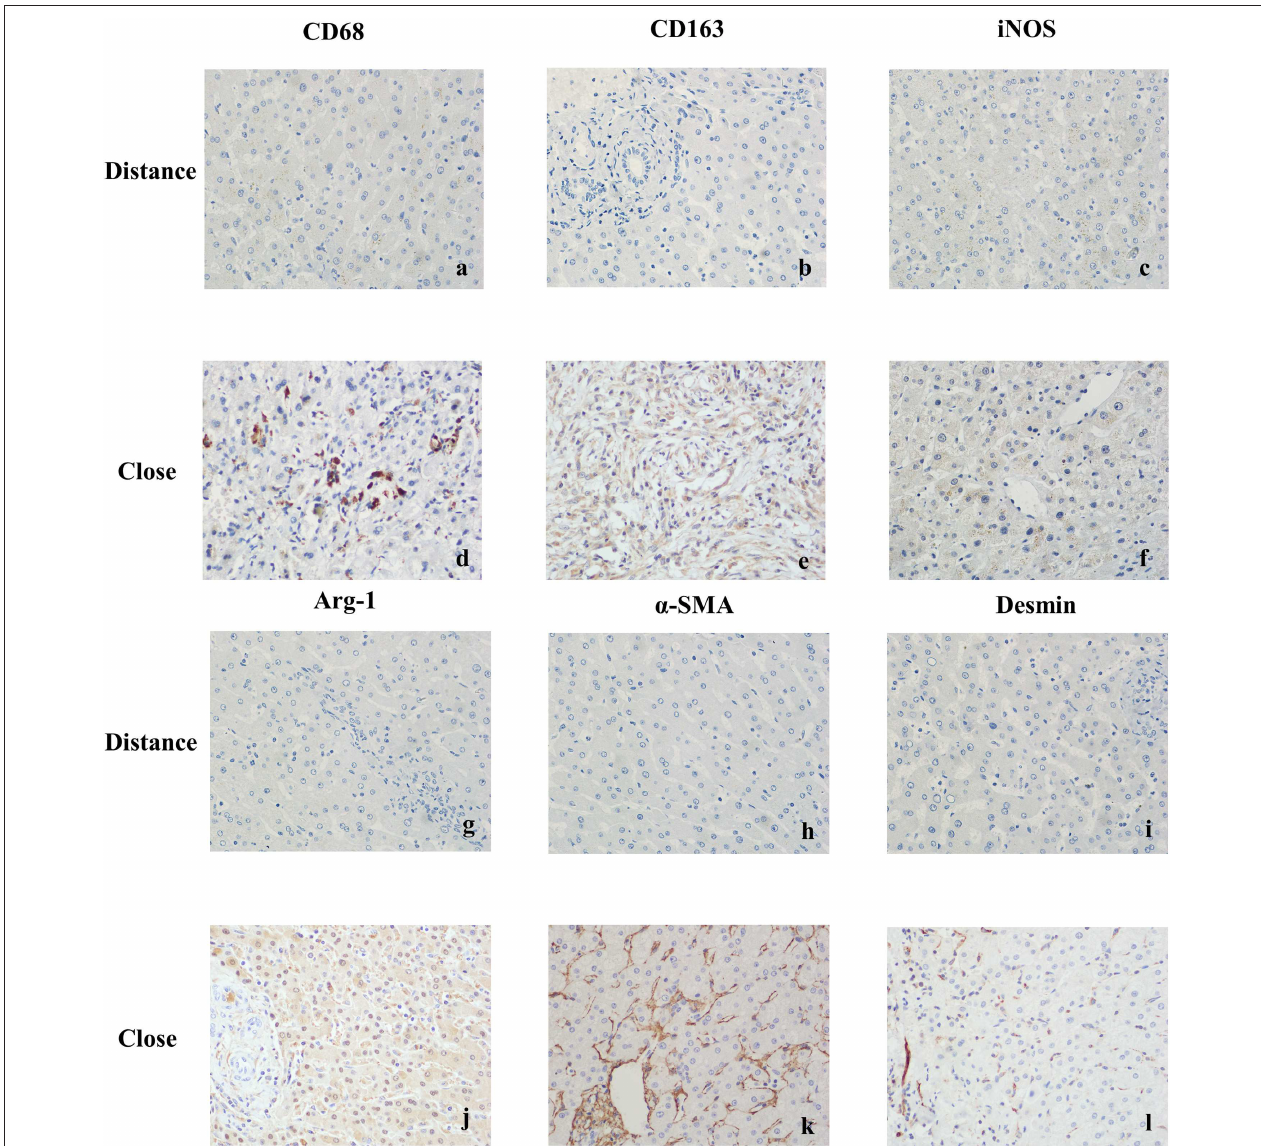
FIGURE 4 | Immunohistochemical staining results of liver tissues in patients with hepatic AE (magnification, × 400). (a) CD68 was weakly positive or negative in KCs cytoplasm (Distance group). (b) CD163 was weakly positive or negative in KCs cytoplasm (Distance group). (c) iNOS was weakly positive or negative in KCs cytoplasm (Distance group). (d) Strong positive expression of CD68 in KCs cytoplasm (Close group). (e) Strong positive expression of CD163 in KCs cytoplasm (Close group). (f) When exposed to inflammatory stimuli, KCs secreted the pro-inflammatory cytokine iNOS, strong positive expression of iNOS in KCs cytoplasm (Close group). (g) Arg-1 was weakly positive or negative in KCs cytoplasm (Distance group). (h) α -SMA was weakly positive or negative in cytoplasm of resting HSCs (Distance group). (i) Desmin was weakly positive or negative in cytoplasm of resting HSCs (Distance group). (j) In the continuous parasite stimulation, KCs secreted the anti-inflammatory cytokineArg-1, strong positive expression of Arg-1 in KCs cytoplasm (Close group). (k) Strong positive expression of α -SMA in cytoplasm of activated HSCs (Close group). (l) Strong positive expression of Desmin in cytoplasm of activated HSCs (Close